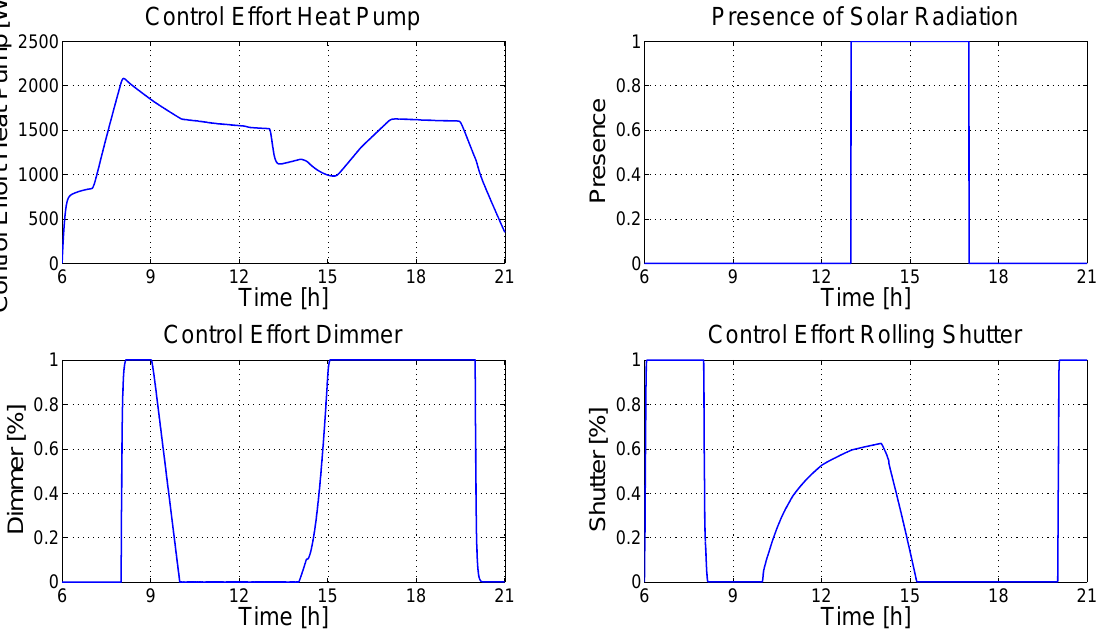
Figure 32. Control results (second scenario, modified control system, Comfort policy): MVs (heat pump, dimmer, and rolling shutters) and DV (presence of solar radiation).